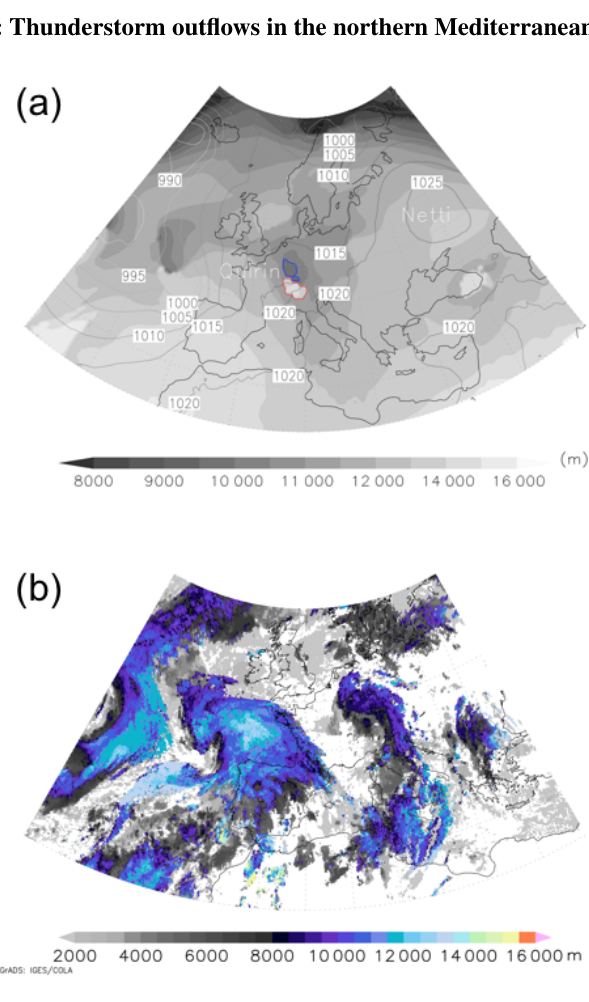
Figure 17. Panel (a) : mean sea level pressure (contours) and tropopause height (shaded contours) over Europe from GFS anal- yses. The red (blue) contour corresponds to the tropopause height equal to 12000 (10000m) to the north of the Alps. Panel (b) : cloud top height from MSG data. Both panels correspond to 4 October 2015 at